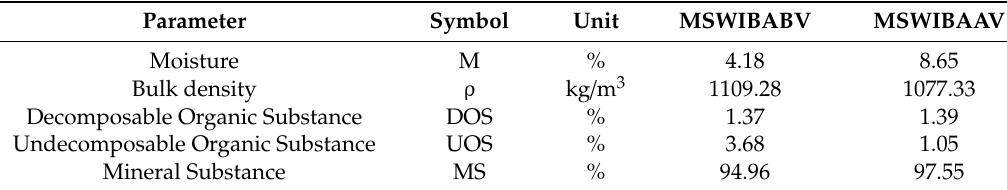
Table 3. Physicochemical properties of bottom slags [14–16].